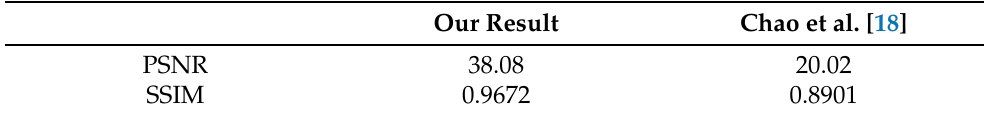
Table 5. For comparison with Chao et al. [18], we evaluate the average PSNR and SSIM for four test images in the dataset as the remaining 20 images are used to train their